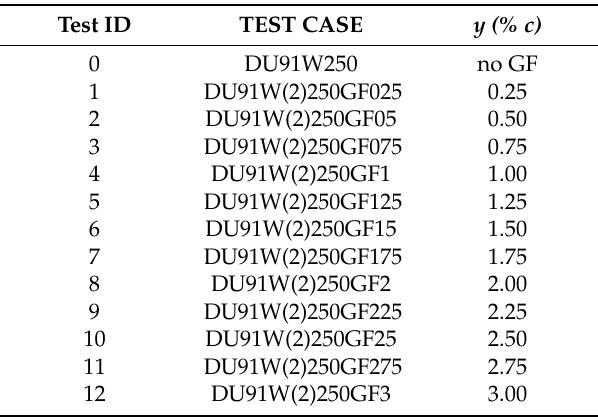
Figure 3. Detailed view of GF on a DU91W(2)250. Table 2. Test cases considered in the study.